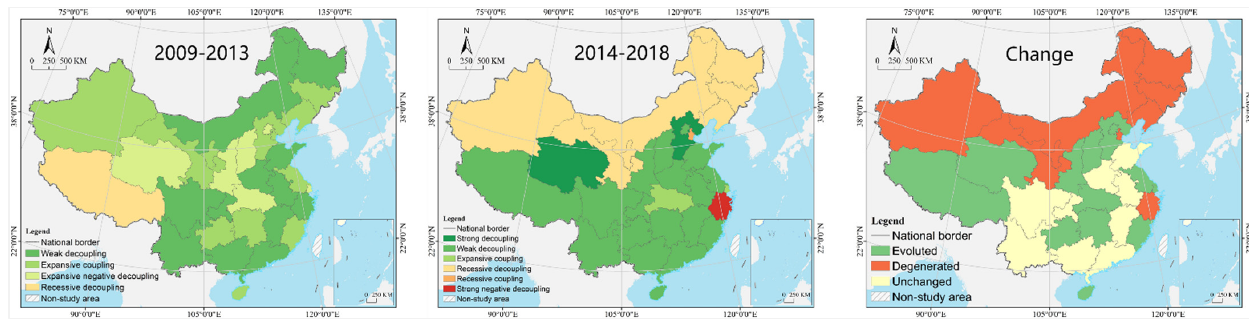
Figure 6. Analysis on the eight types of decoupling relationships in gross output value.